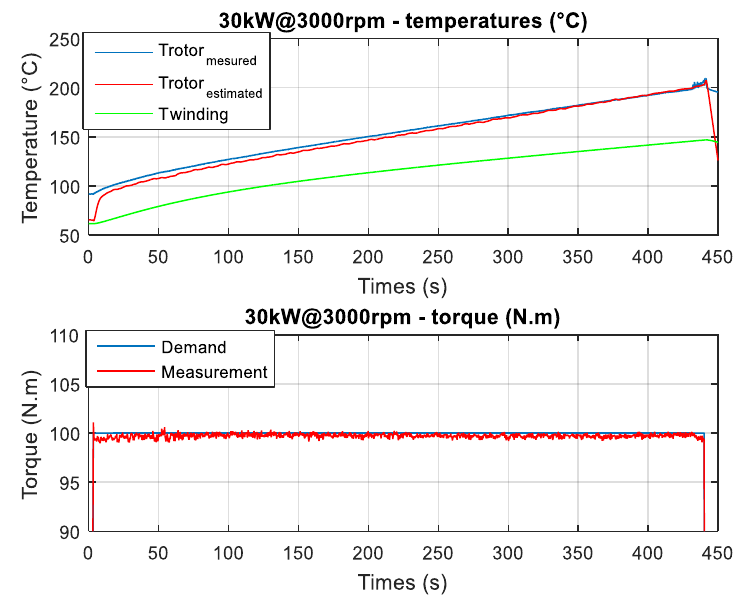
Figure 9. Comparison of temperatures found by estimator against pyrometer and torques at 100 N · m and 3000 rpm.